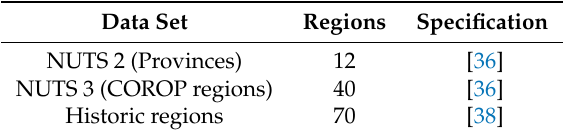
Table 3. Different sets of identity regions embedded in the human migration